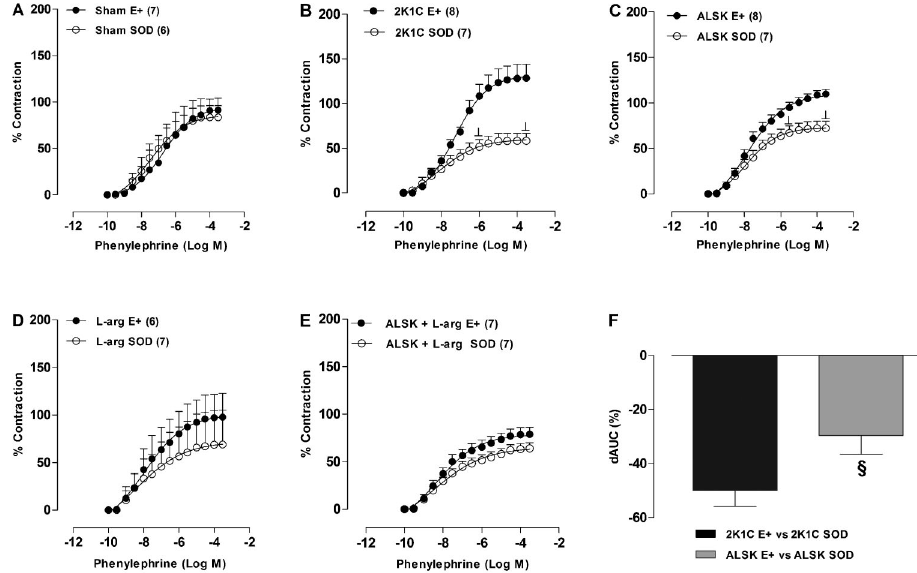
Figure 7. Effects of superoxide dismutase (SOD, 150 U/mL) on the concentration-response curves to phenylephrine in endothelium- intact aortic segments from Sham ( A ), 2K1C ( B ), aliskiren (ALSK) ( C ), L-arginine (L-arg) ( D ), and ALSK++L-arg ( E ) treatments in aortic rings in the presence (SOD) and absence (E++) of SOD incubation. The differences in the area under the concentration-response curves (dAUC) in the presence and absence of SOD are shown in F . Data are reported as means±SE. The number of animals in each group is indicated in parentheses. 1 P , 0.05 vs 2K1C and H P , 0.05 vs E++ (two-way ANOVA, followed by Tukey’s post hoc test).